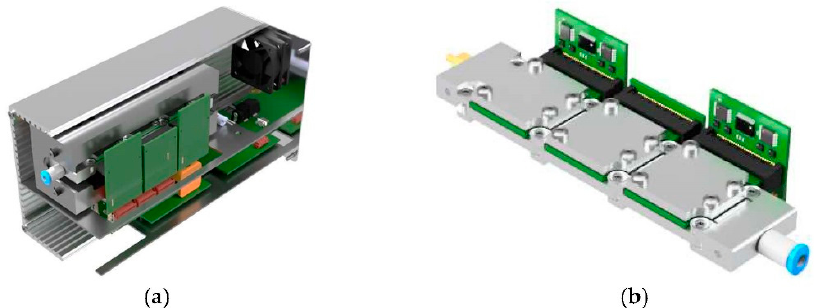
Figure 1. ( a ) Novel modular eNose system based on commercial MOX sensors (completely assembled); ( b ) sensing chamber with three individual compartments, shown here as a combination of analog–digital–analog MOX sensor compartments.